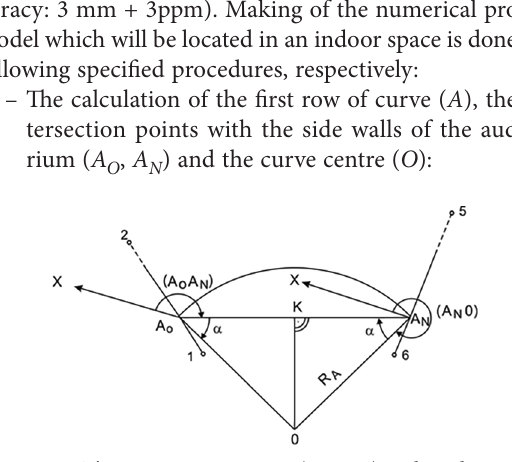
1 P 2 , P 6 P 5 lines) of the curve in the first